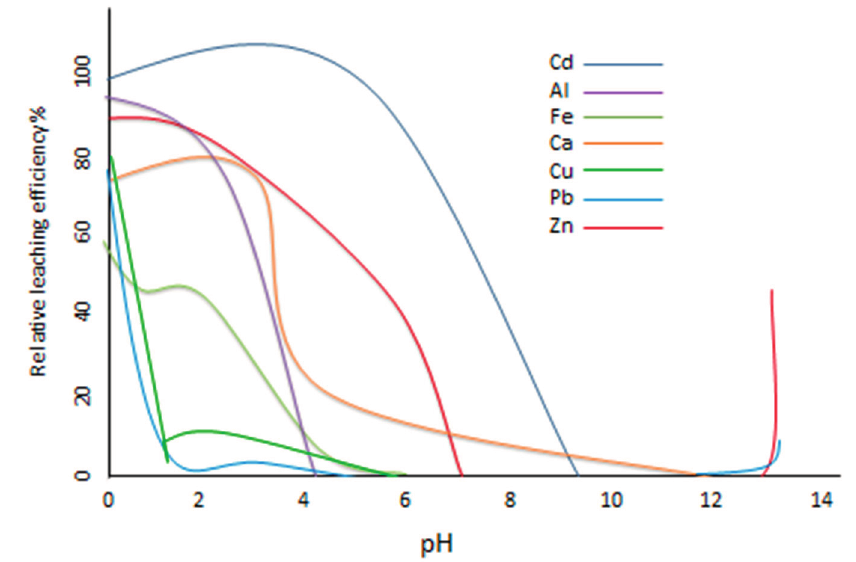
Figure 3. Relative leaching efficiency (%) of elements as a function of the final pH for MSWI (municipal solid waste incinerator) fly ash [155].